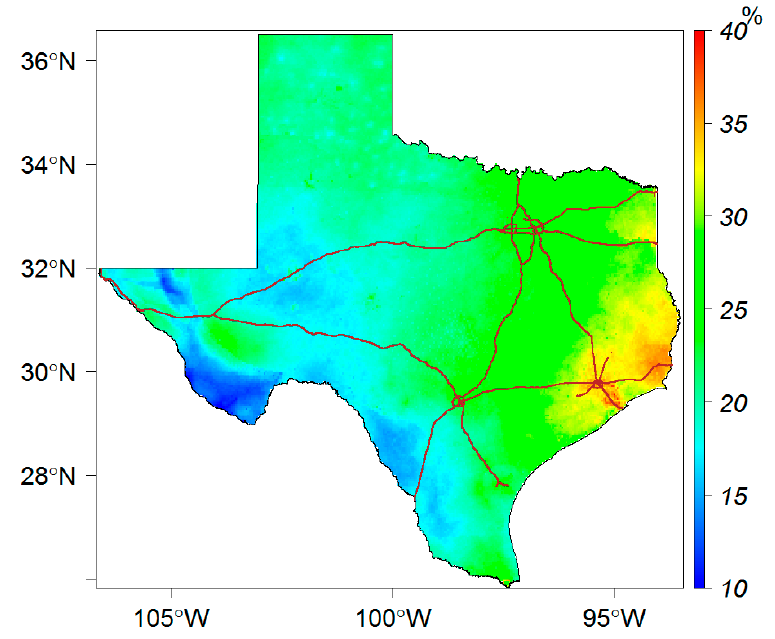
Figure 2. Spatial distribution of daily average precipitation frequency in the State of Texas.